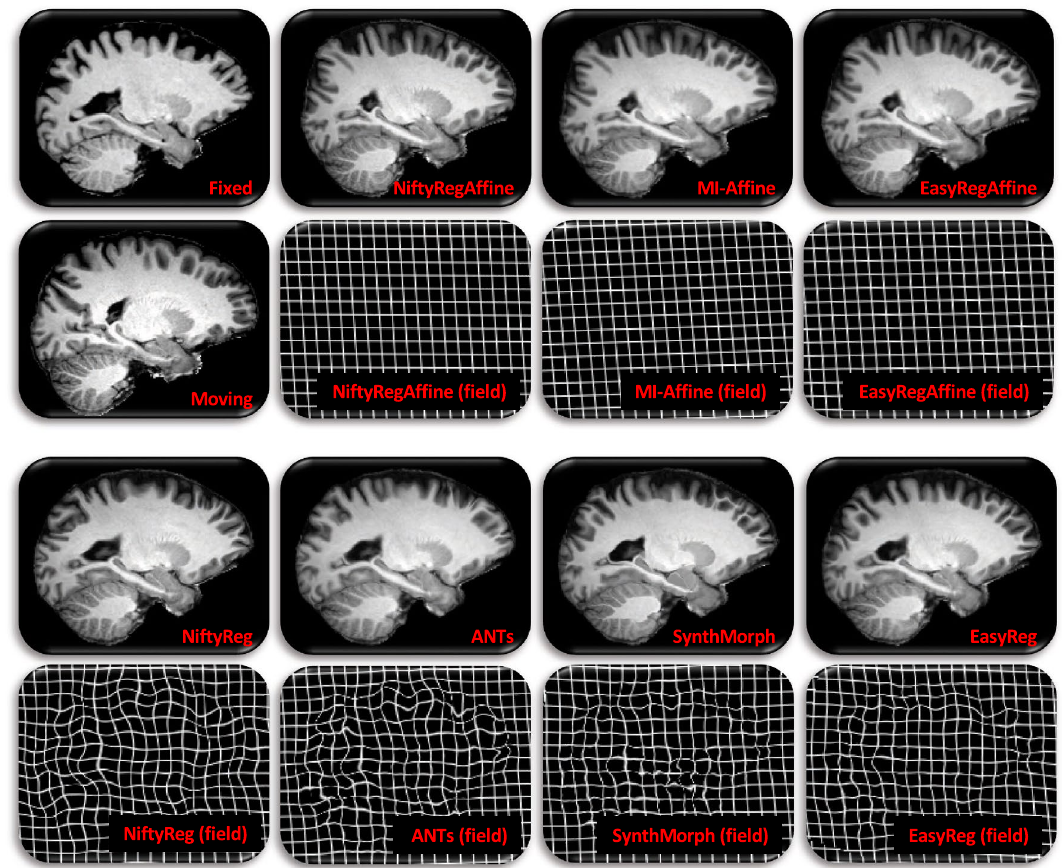
Figure 4. Sample registration from T1–T1b setup, i.e., MindBoggle to IXI Top left: sagittal slices of fixed and moving images. Rest: corresponding registered slice and deformation field (represented as a deformed grid) for the seven competing